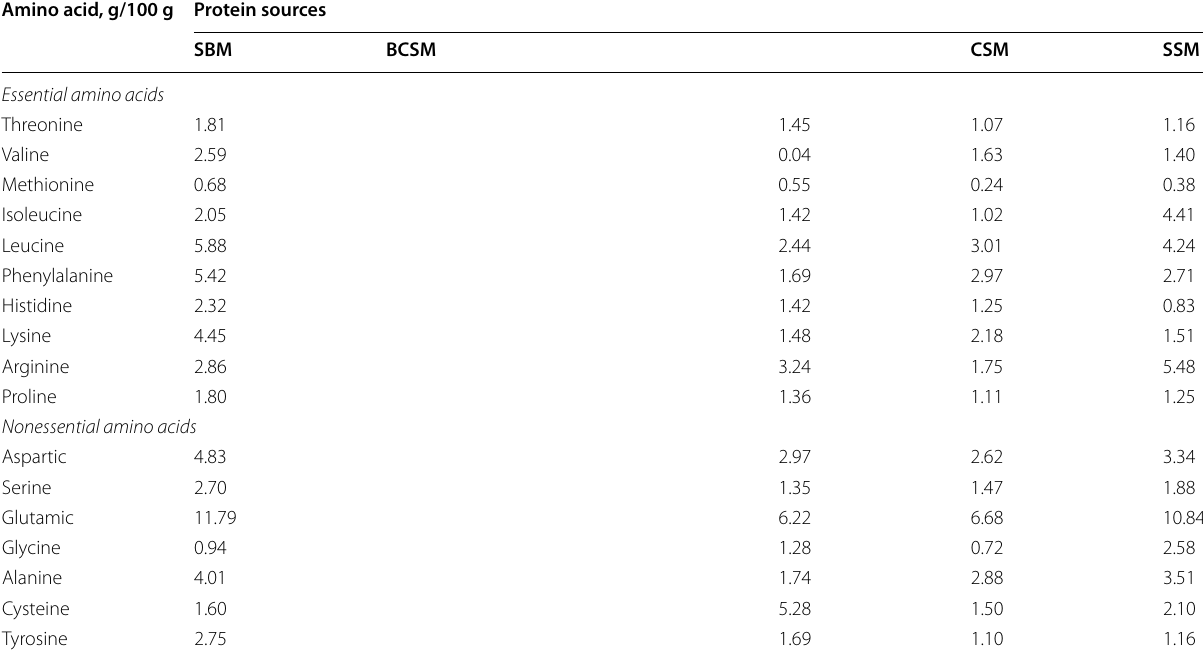
Table 2 Amino acids content of tested protein sources Amino acid, g/100 g Protein